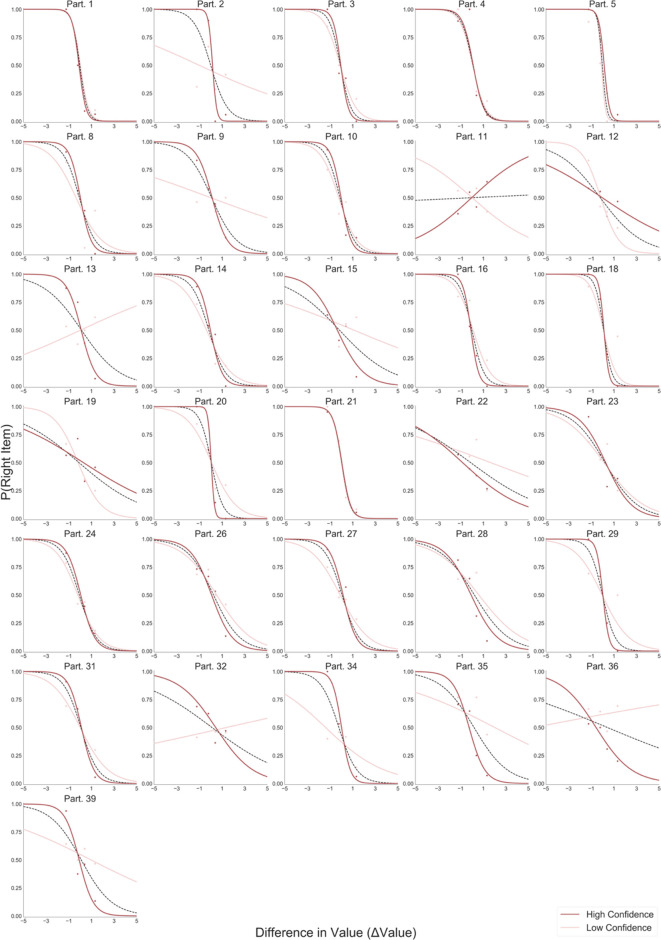
Logistic regression predicting choice from the difference in value between the two items (∆Value).All participants in the Value Experiment, dislike frame, are presented. Light red lines depict the logistic fit calculated using low confidence trials. Dark red lines show the logistic fit using high confidence trials. Segmented black line considers the logistic regression calculated with all the trials.